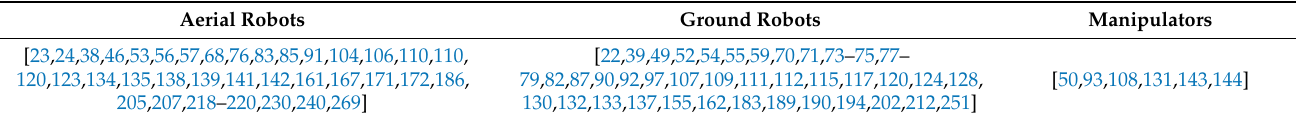
Table 3. Types of robots in the reviewed papers. If the type is not specified in the paper, it is not listed